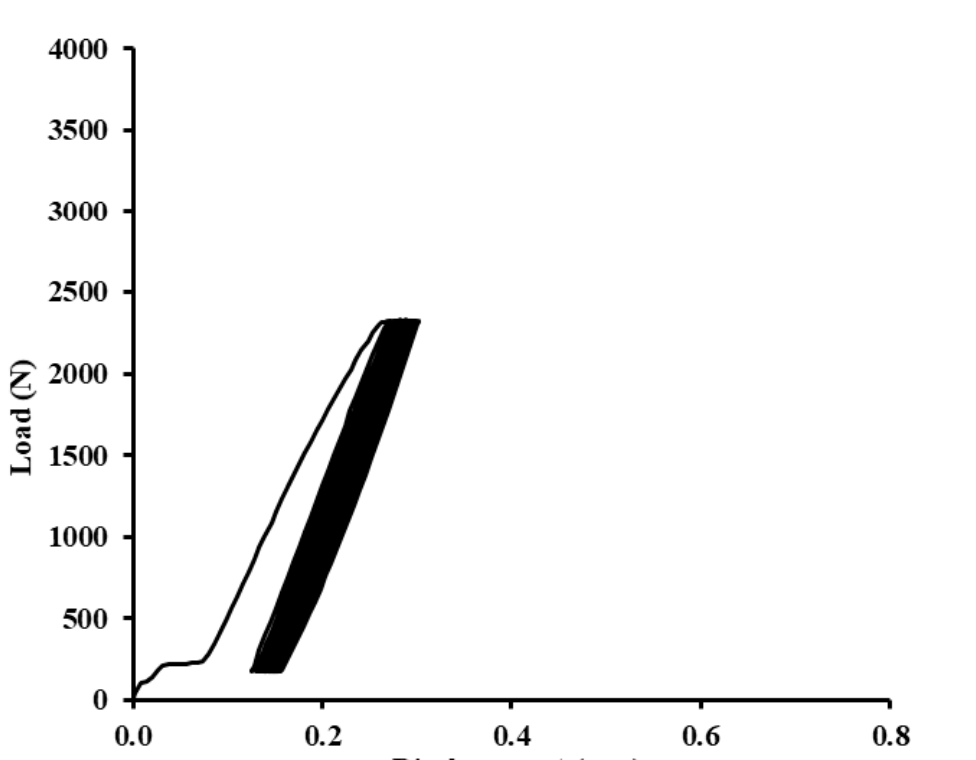
Figure 12. Quasi-static graph of adhesive bond ABFE1 with loading 5–30% (165–989 N)—1000 cycles.